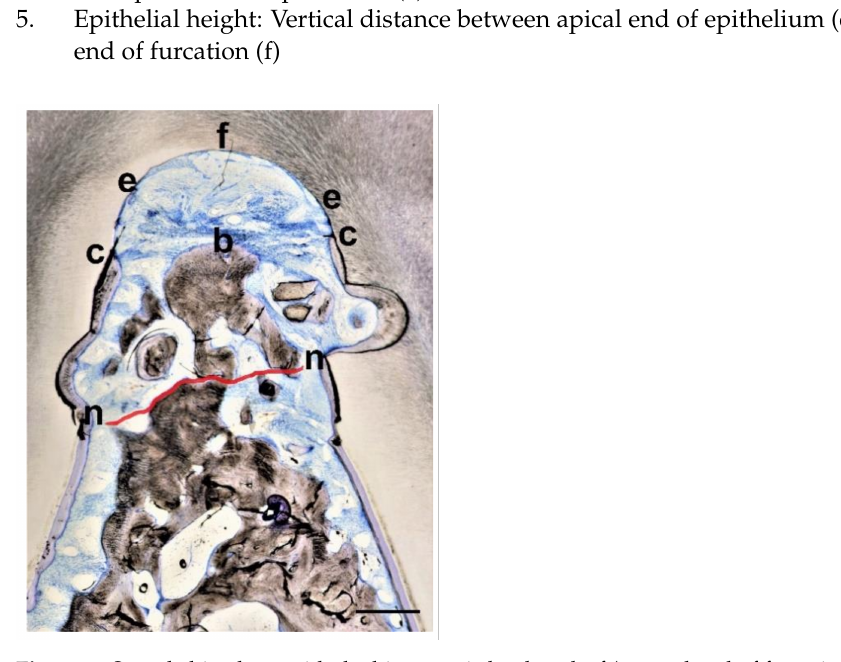
Figure 2. Sample histology with the histometric landmarks f (coronal end of furcation), n (apical end of notch), b (coronal end of newly formed bone), c (coronal end of newly formed cementum), and e (apical end of epithelium). Red line delineates old bone (below the red line) from newly formed bone (above the red line). Bar in lower right corner represents 0.5